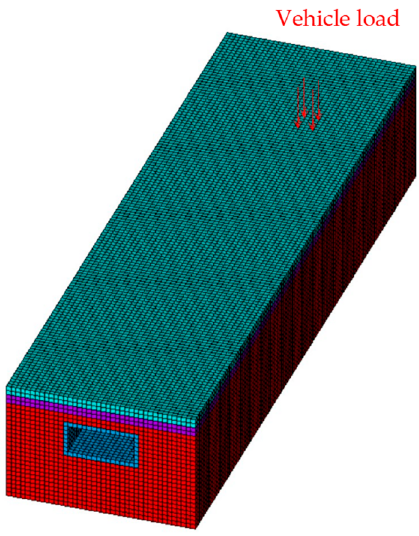
Figure 11. Schematic diagram of numerical calculation loading.